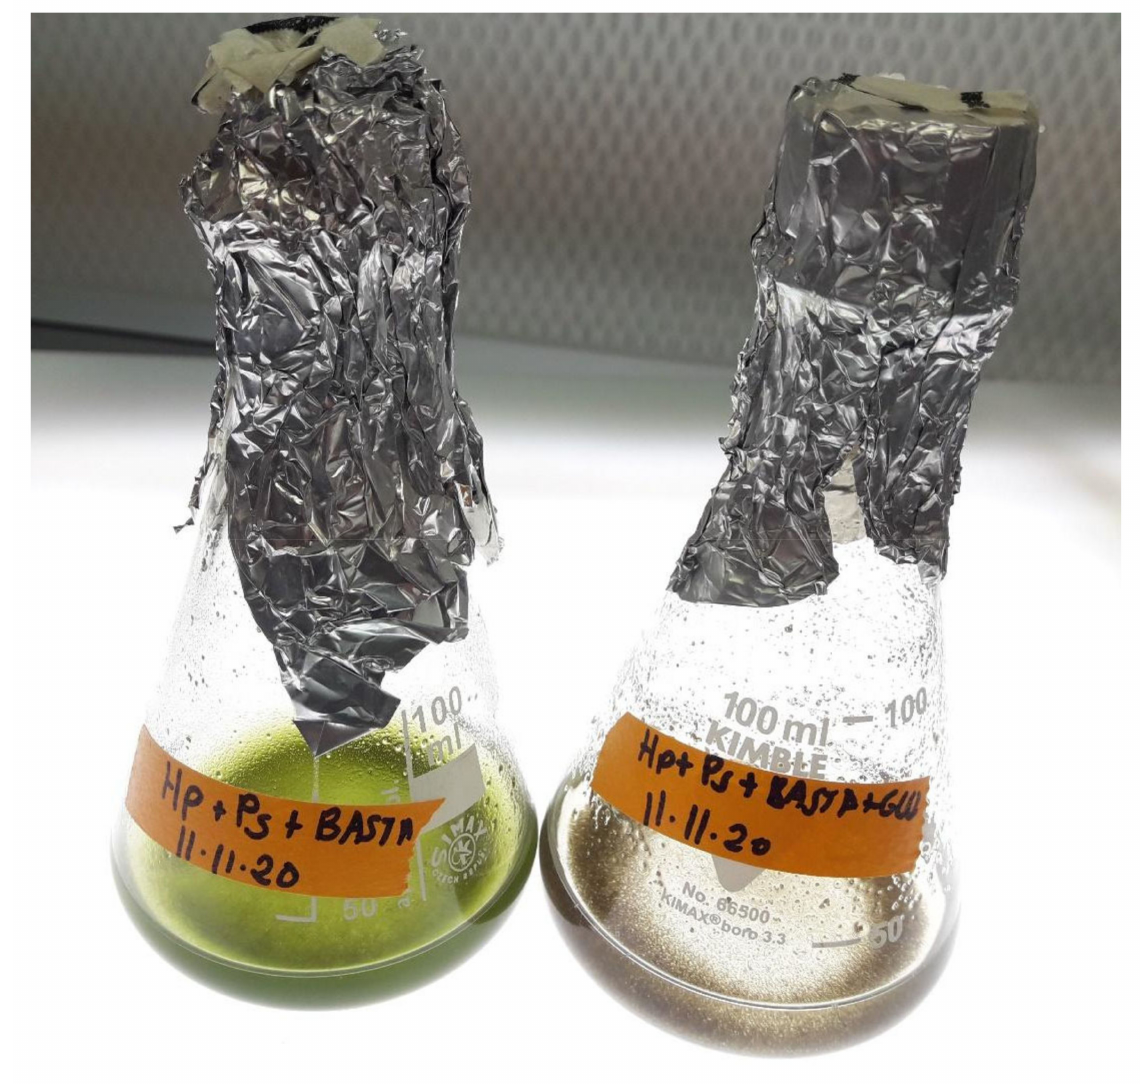
Figure 3. Addition of glutamine abolishes the inhibitory effect of glufosinate on the infection of H. lacustris by P. sedebokerense propagules. Shown are flasks of H. lacustris and P. sedebokerense cocultures after 7 days. Left: coculture in the presence of 2.5 mM of glufosinate; Right: coculture in the presence of 2.5 mM of glufosinate and 12.5 mM of